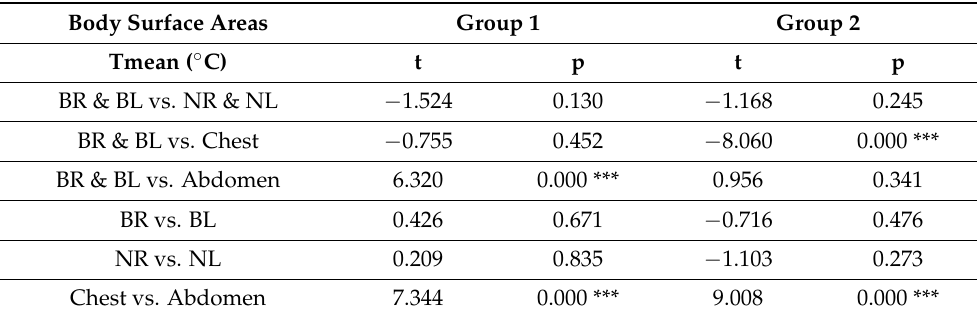
Table 3. The results of the significance test of differences (Student’s t -test) between the analyzed T mean values of selected areas of the female body in age groups.